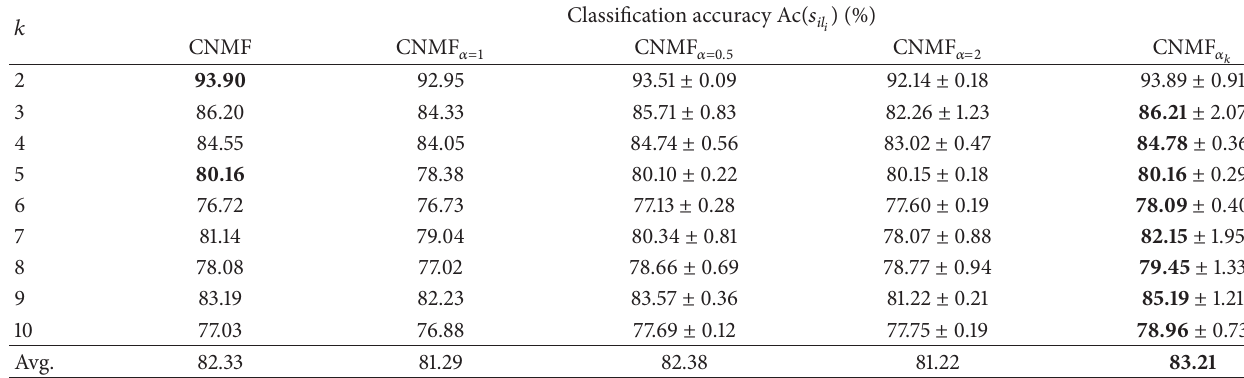
Table 1: The comparison of classification accuracy rates on the ORL Database.